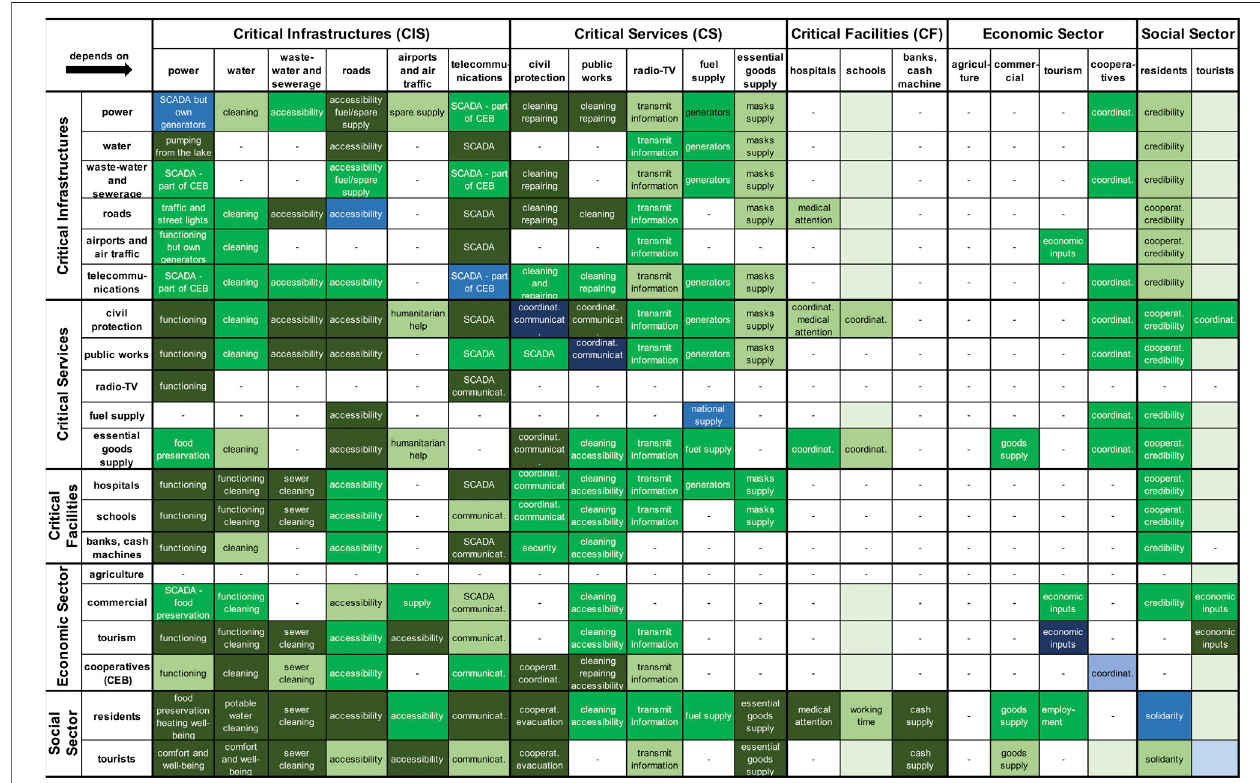
FIGURE 5 | Matrix showing the relations of dependency among different sectors in SCB. Colour scales indicate the dependency index where intra-dependencies beetween the same system (blue scale) and inter-dependencies beetween different systems (green scale) have been analysed. Each of these colour scales consists of four degrees of dependency from none – no direct or indirect dependencies (pale color), through low dependency – not relevant issues if missing (light color), medium dependency – dependent but can continue functioning (bright color), to high dependency – totally dependent and cannot continue functioning (dark color). White cells with hyphen indicate no available data. Cooperatives refer only to the Cooperative of Electricity of Bariloche (CEB). SCADA refers to the Supervisory Control And Data Acquisition. (For a better readibility, these colour scales are available in the Supplementary Figure S2 ).